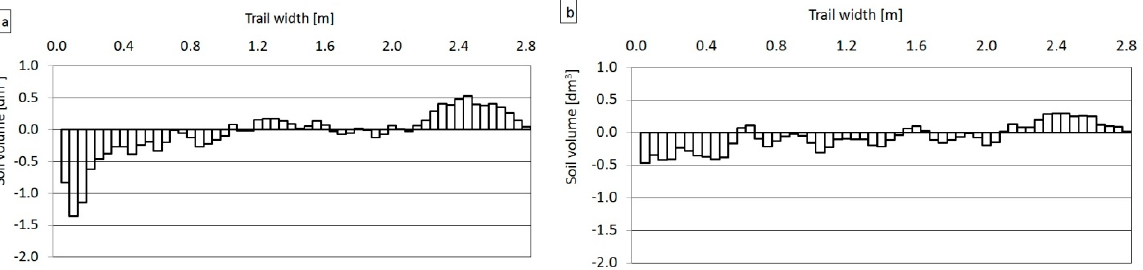
Figure 10. Changes in soil volume on trail sections before and after skidding: ( a ) Ht130U and ( b ) Ht130L.